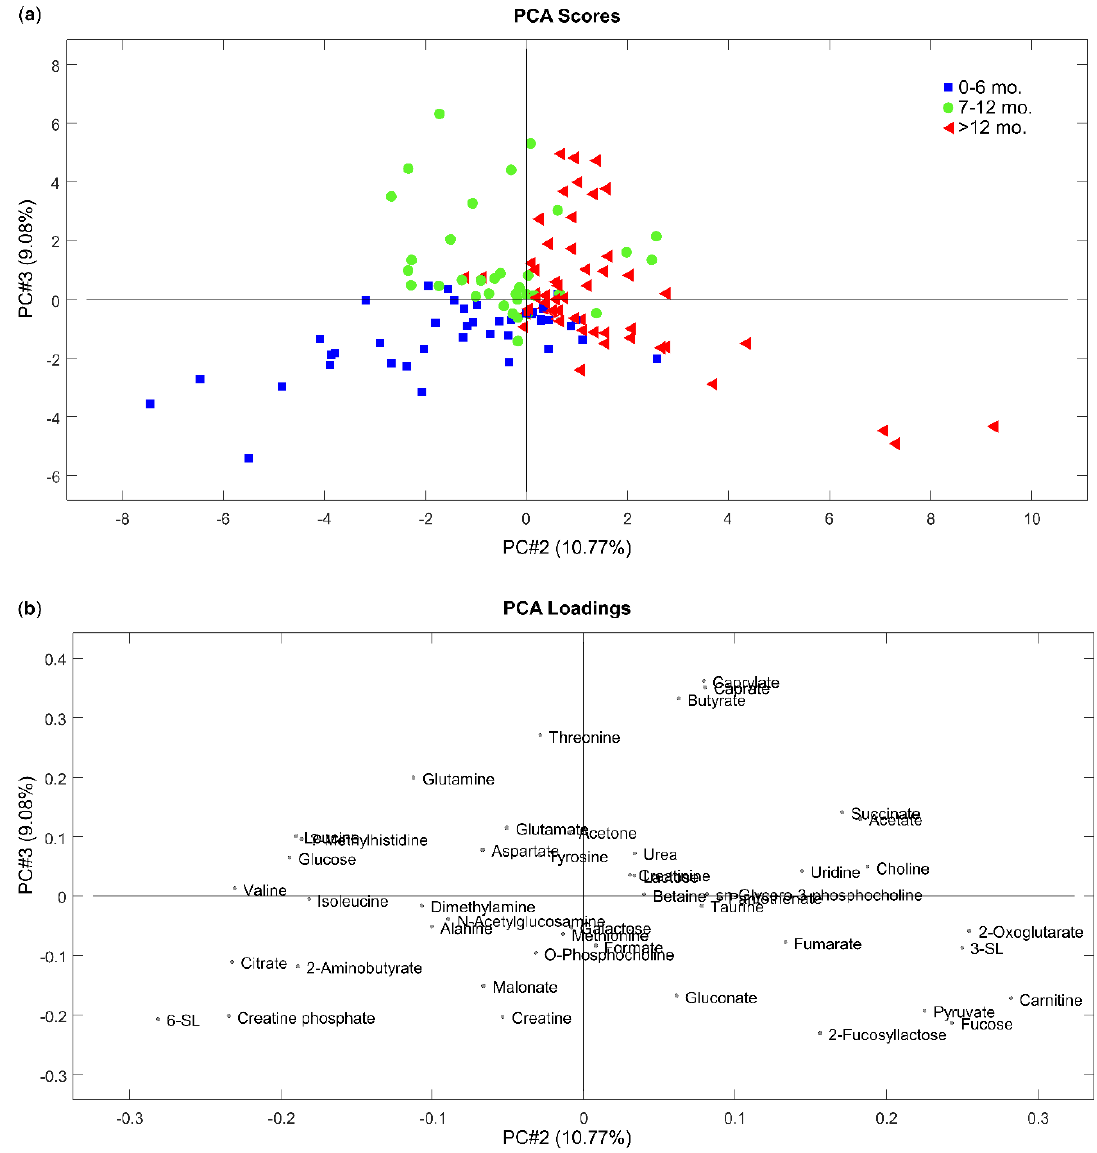
Figure 2 . Principal component analysis (PCA) of human breast milk ( HBM ) samples. (a) Scores plot; Figure 2. Principal component analysis (PCA) of human breast milk (HBM) samples. ( a ) Scores plot; and (b) loading plot. and ( b ) loading